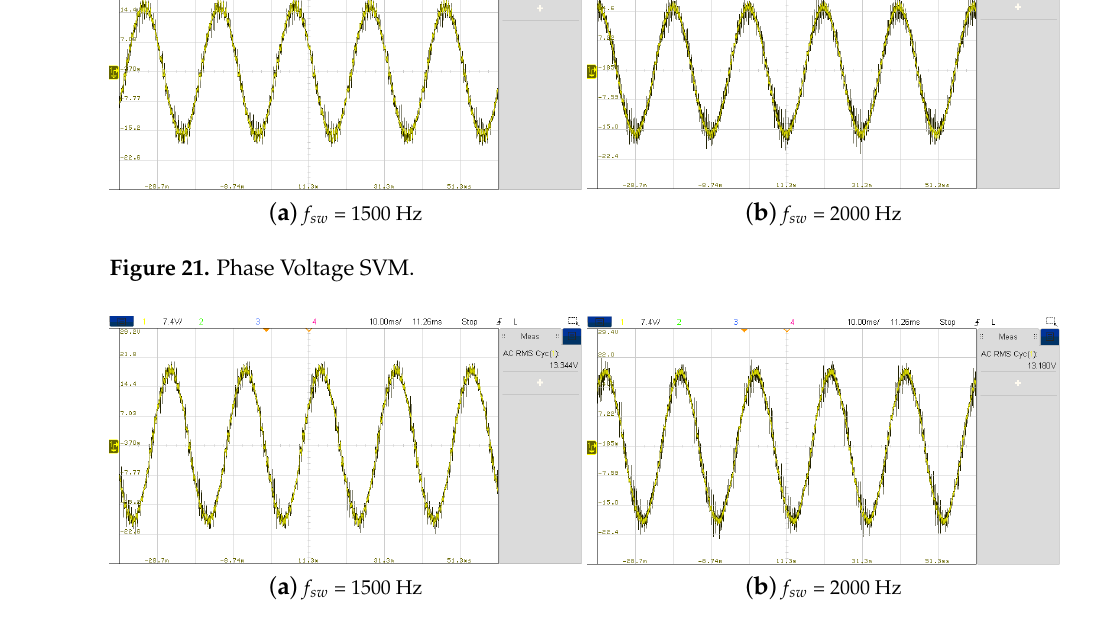
Figure 22. Phase voltage SVM-FSM.